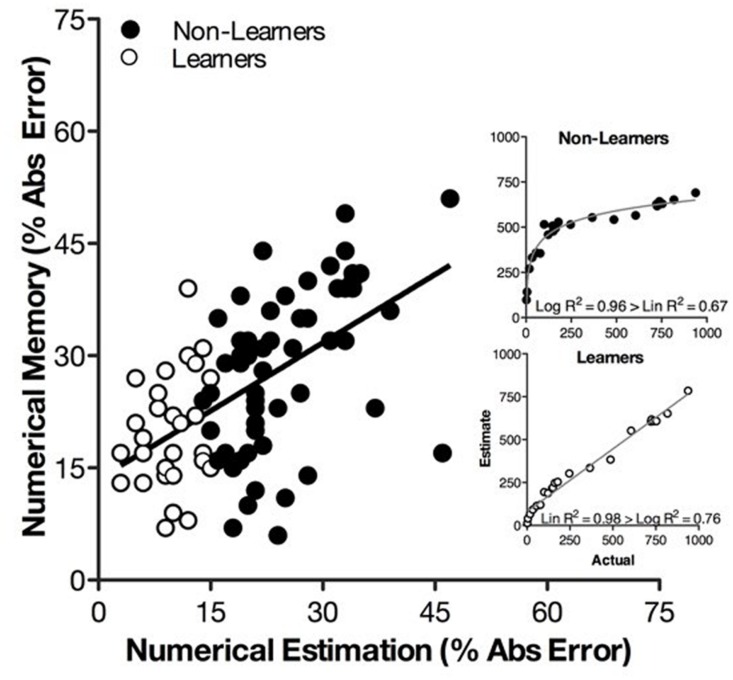
Percent absolute error on the numerical estimation task is strongly correlated with PAE on the numerical memory task for non-learners (black circles) and learners (white circles). The inset figures illustrate a logarithmic-to-linear shift in numerical estimation across non-learners and learners.